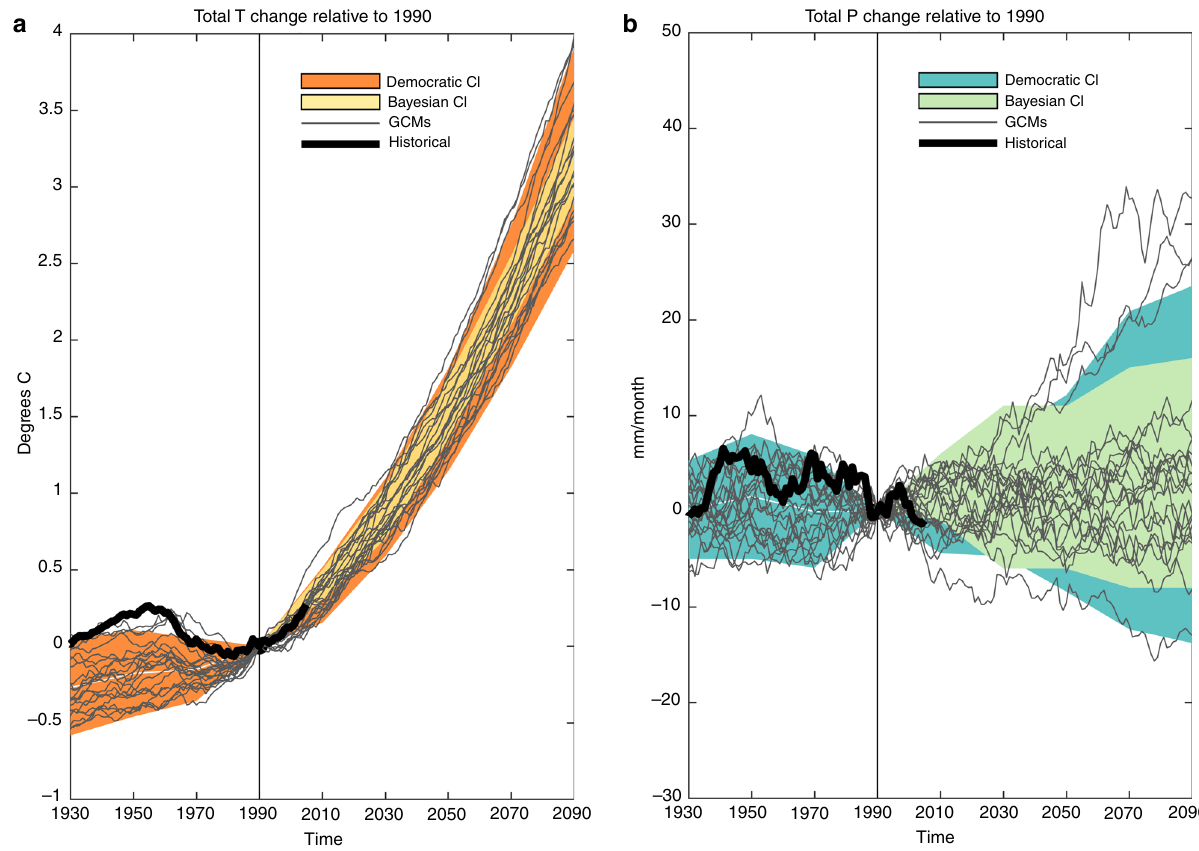
Fig. 2 Bayesian and democratic con fi dence intervals from GCM projections. a and b Modeled and observed temperature (precipitation) relative to 1990 values with uncertainty estimates. Thin gray lines are 20-year moving averages of GCM simulations over Mombasa. Thick black lines show the corresponding historical observed values. Orange (blue) shaded regions show the 90% CIs using the IPCC democratic weighting method (i.e. ±1.64* σ ). Yellow (green) shaded regions show the 90% CI developed using the Bayesian uncertainty method applied to historical regional observations before